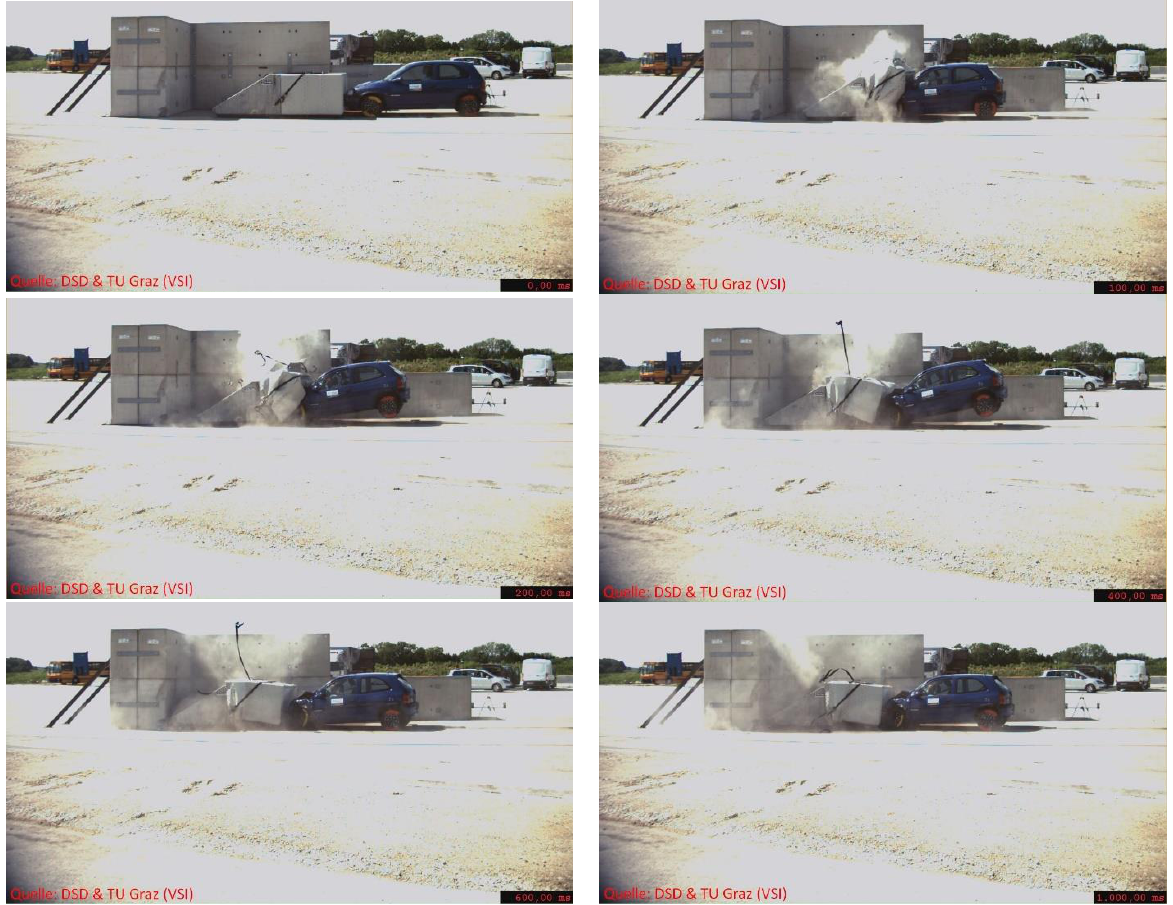
Figure 10. Vehicle motion impacting the crash cushion Alpina F1-50. The vehicle was fully decelerated and moved backwards due to the elastic restitution. The final position was approximately 0.4 m in front of the damaged crash cushion. Table 6. Summary of the results of the assessment of the safety